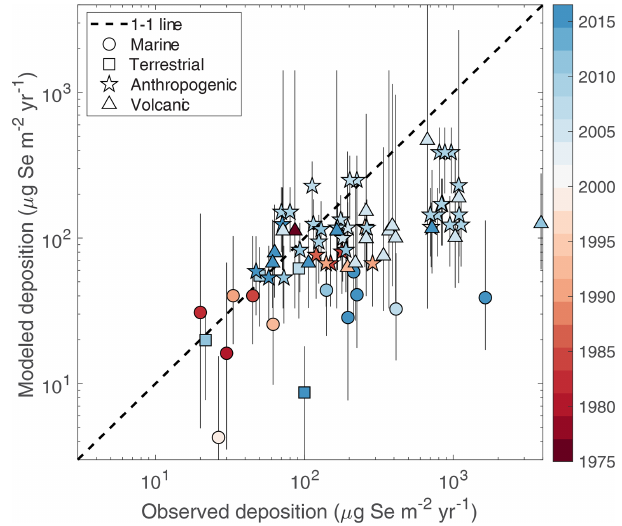
Figure 12. Comparison of wet deposition flux measurements (Ta- ble 5) with modeled fluxes. Medians for the modeled values are shown, along with vertical bars representing the 2nd and 98th per- centile values. The symbols correspond to the model input param- eter that is most important for deposition at the measurement loca- tion. The color of the symbols represents the year when the mea- surement was taken; multi-year measurements show the middle